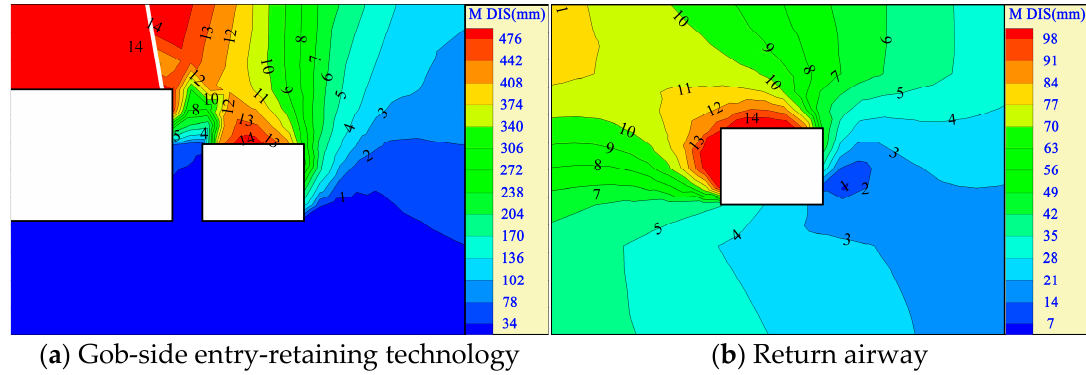
Figure 18. Roadway deformation after roof cutting.